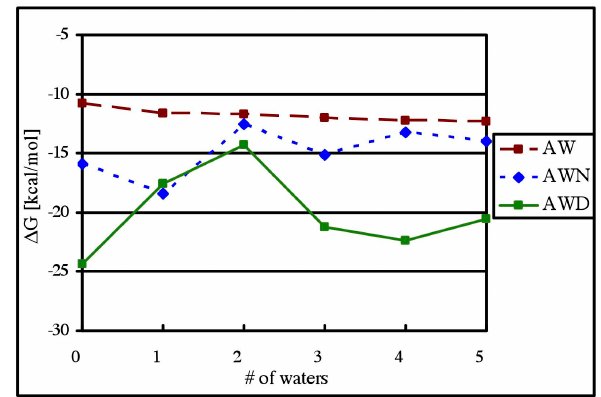
molecule to the clusters containing one sulfuric acid and 0–5 water molecules. AW: clusters with only sulfuric acid and water; AWN: clusters containing one sulfuric acid and an ammonia molecule; AWD: clusters containing one sulfuric acid and a dimethylamine